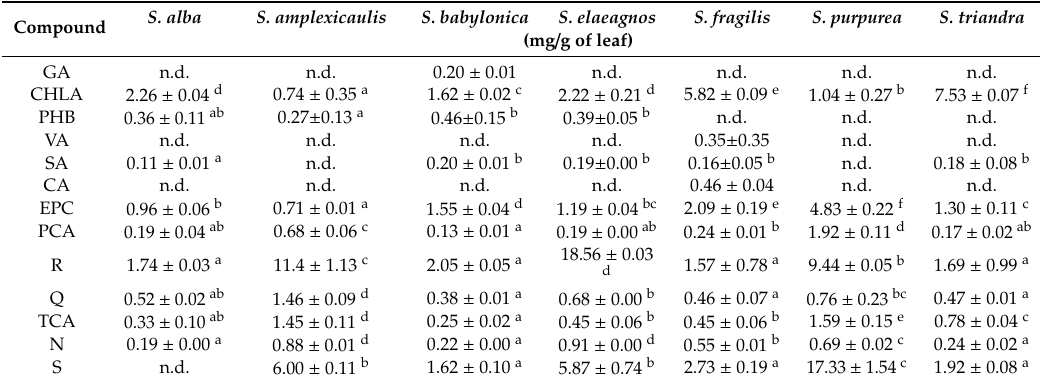
Table 3. Phytochemical characterization of leaves